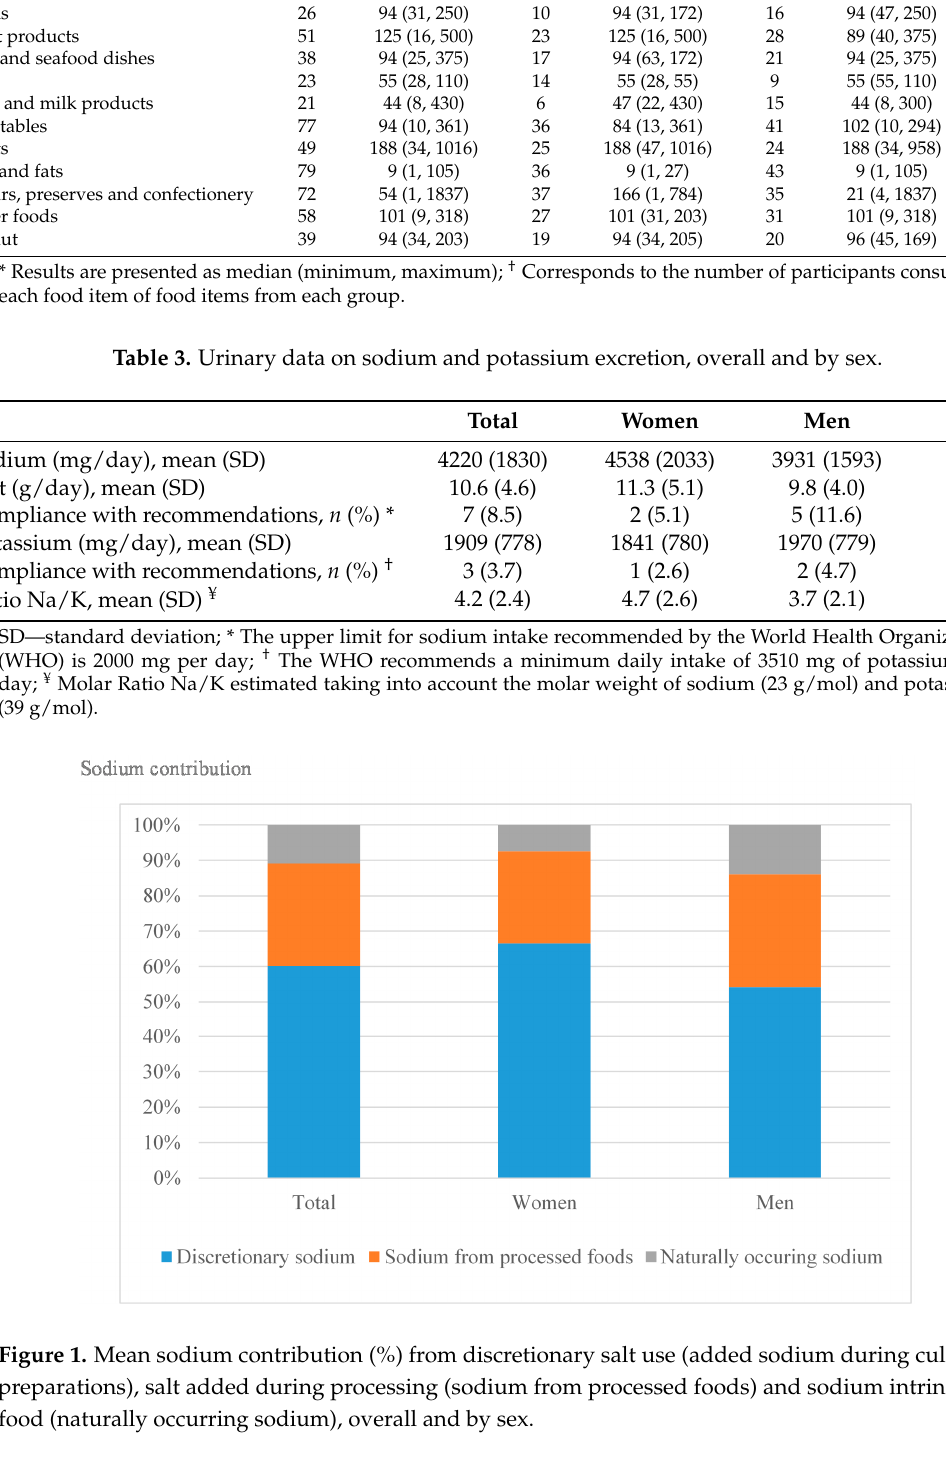
Table 2. Dietary intake of the studied sample, overall and by sex.